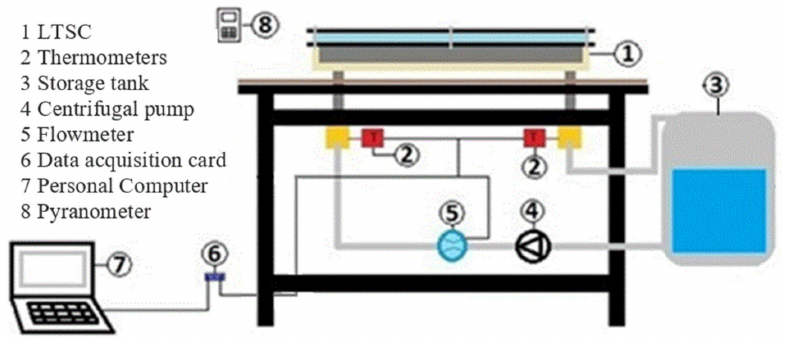
Figure 10. Scheme of the test rig.